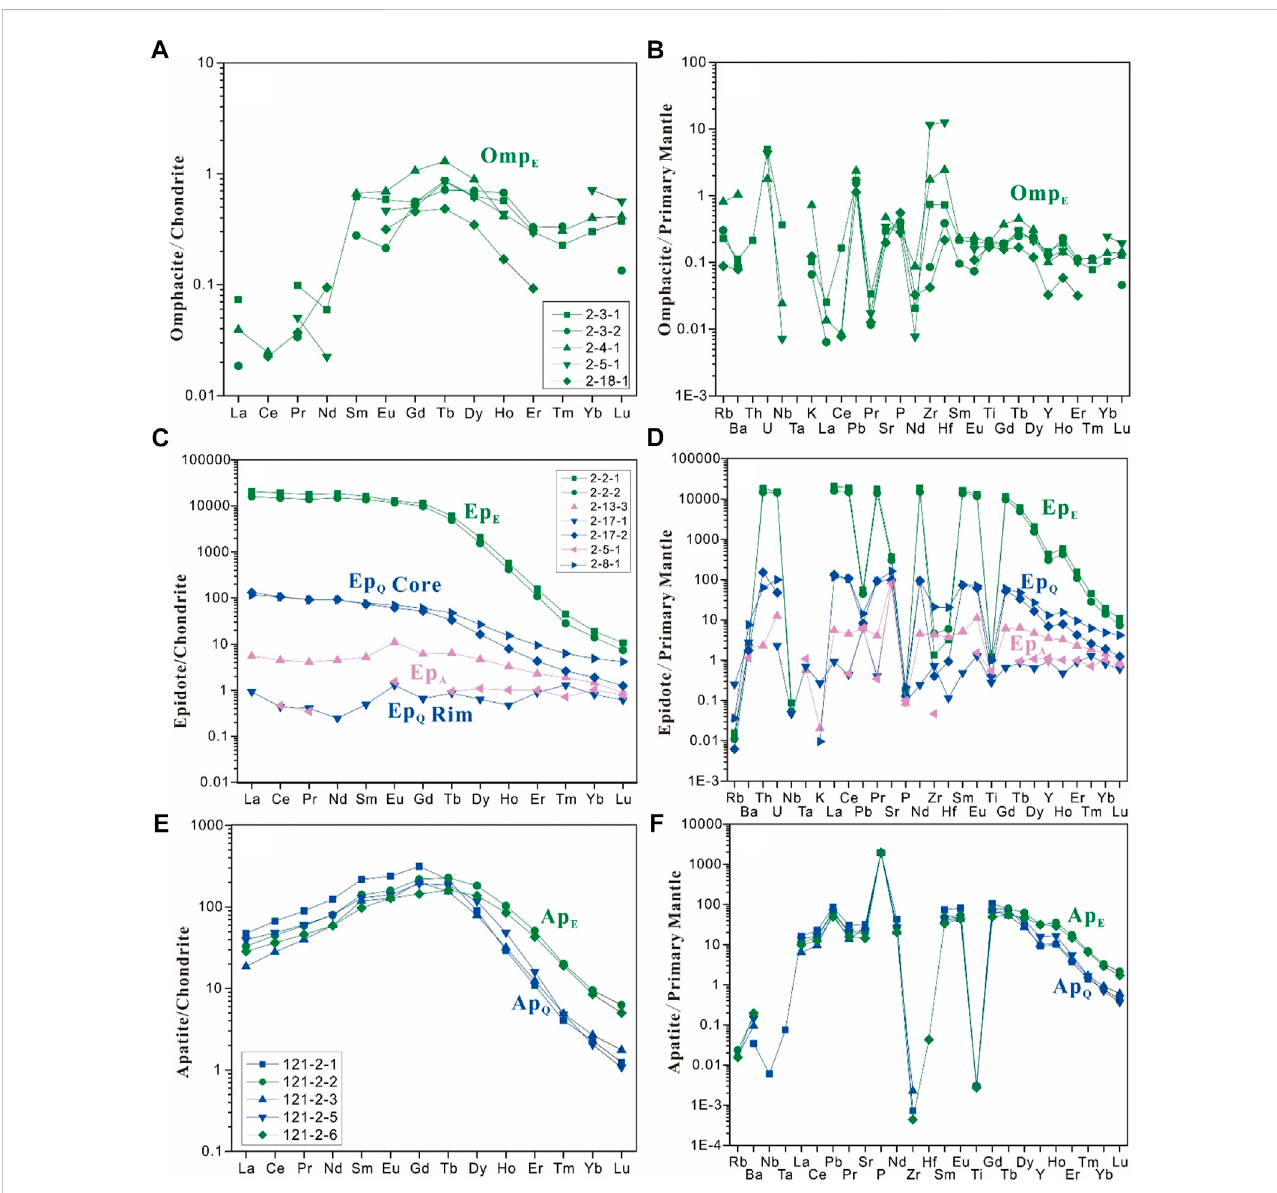
Chondrite-normalizedREEpatterns(leftpanels)andprimarymantle-normalizedtraceelementpatterns(rightpanels)ofomphacite (A,B) ,epidote (C,D), and apatite (E, F) from the sample